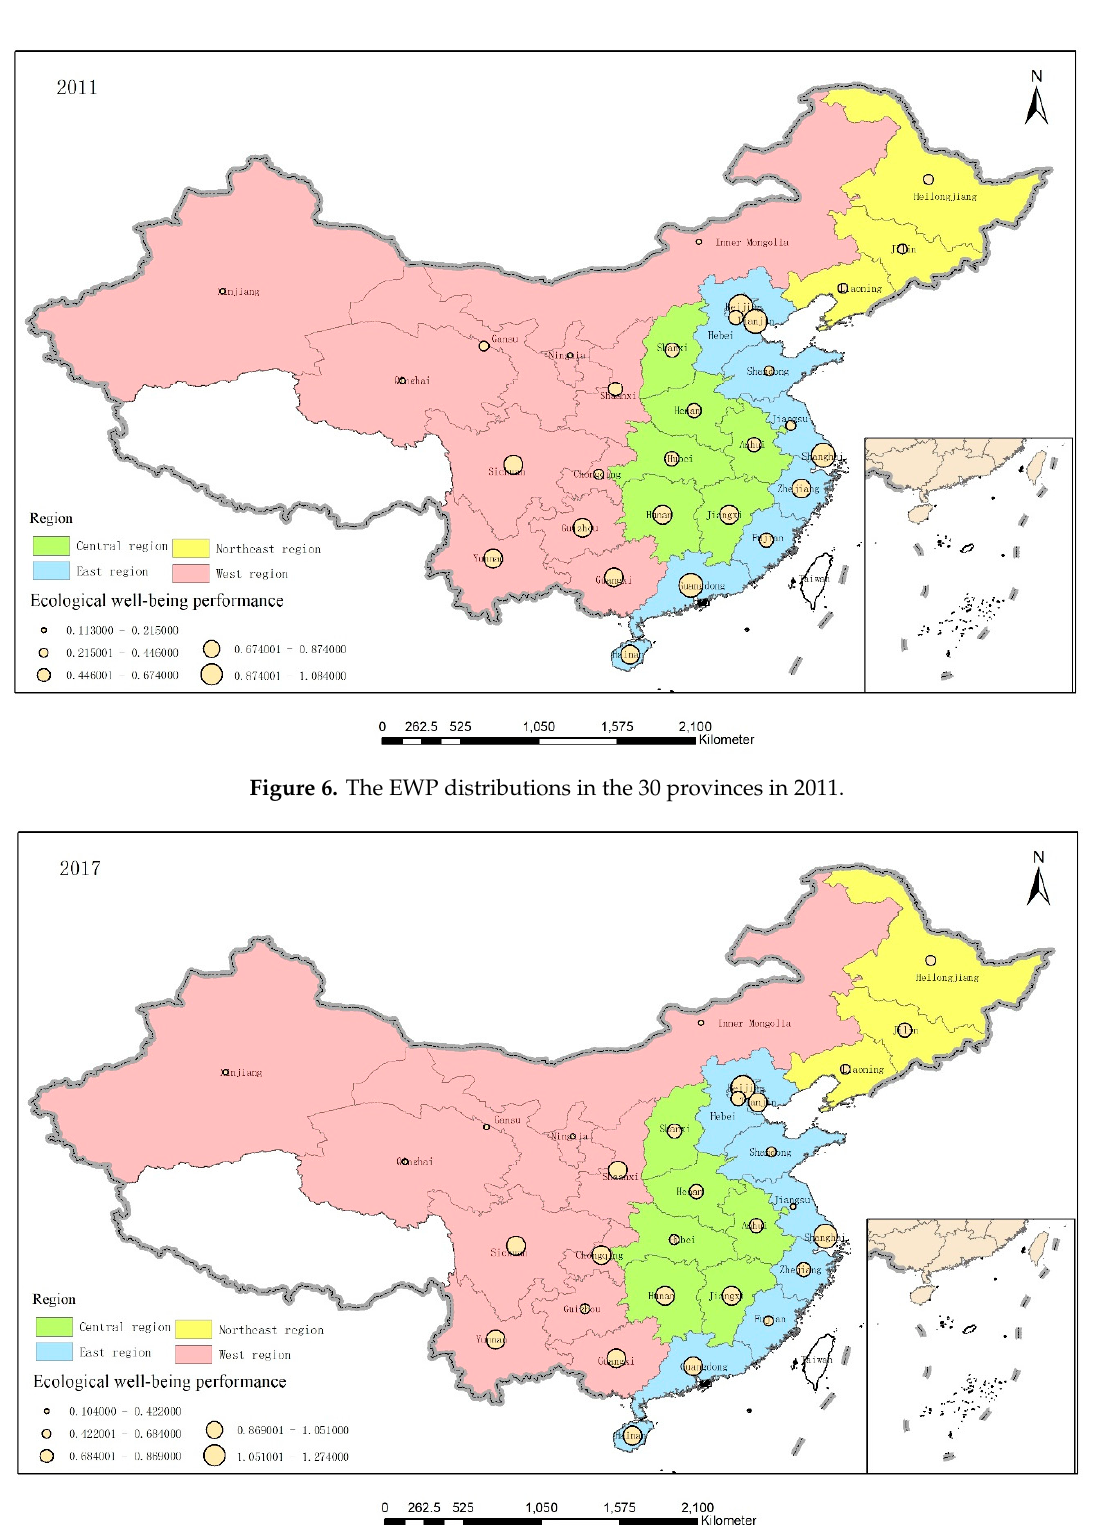
Figure 5. The EWP distributions in the 30 provinces in 2006.